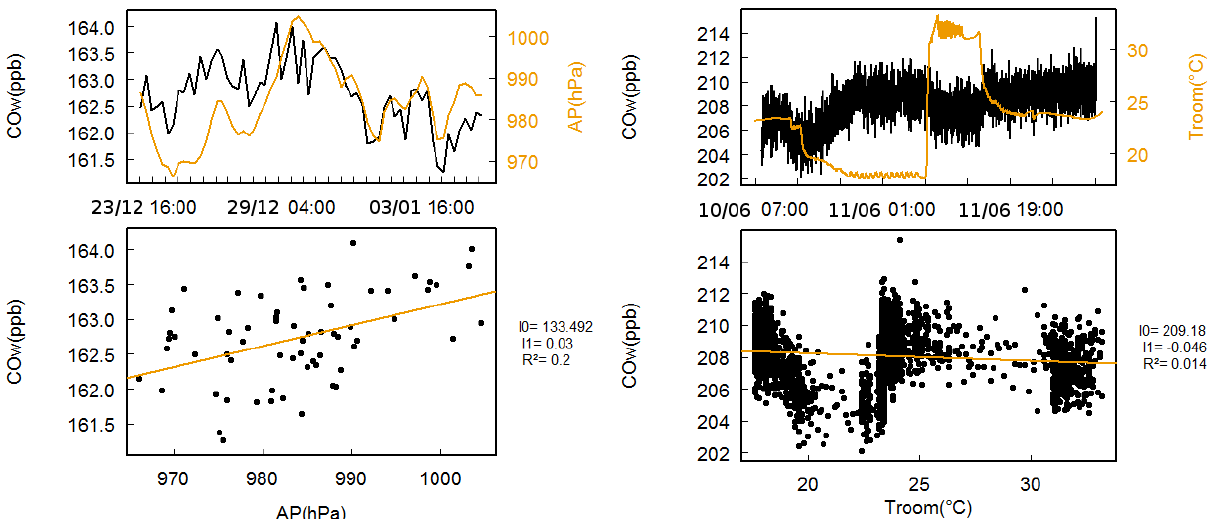
Figure A3. CO pressure and temperature dependency. First panel: pressure dependency. Second panel: temperature dependency. On the right of the lower plot, the slope (I1), intercept (I0) and the coefficient of correlation ( R 2 ) are indicated.